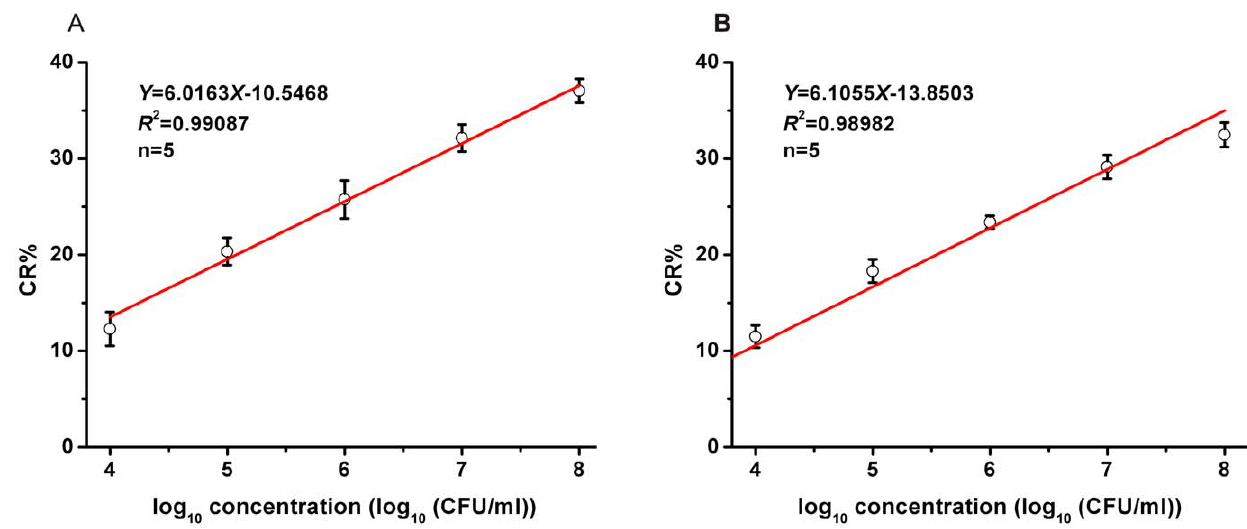
Figure 6. Calibration curve for CR% vs. concentration of E . coliO 157:H7 using by different PDA vesicles. (A) CR% of E17F-37/PCDA vesicles with E. coli O 157:H7. (B) CR% of E18R-42/PCDA vesicles with E. coli O 157:H7.